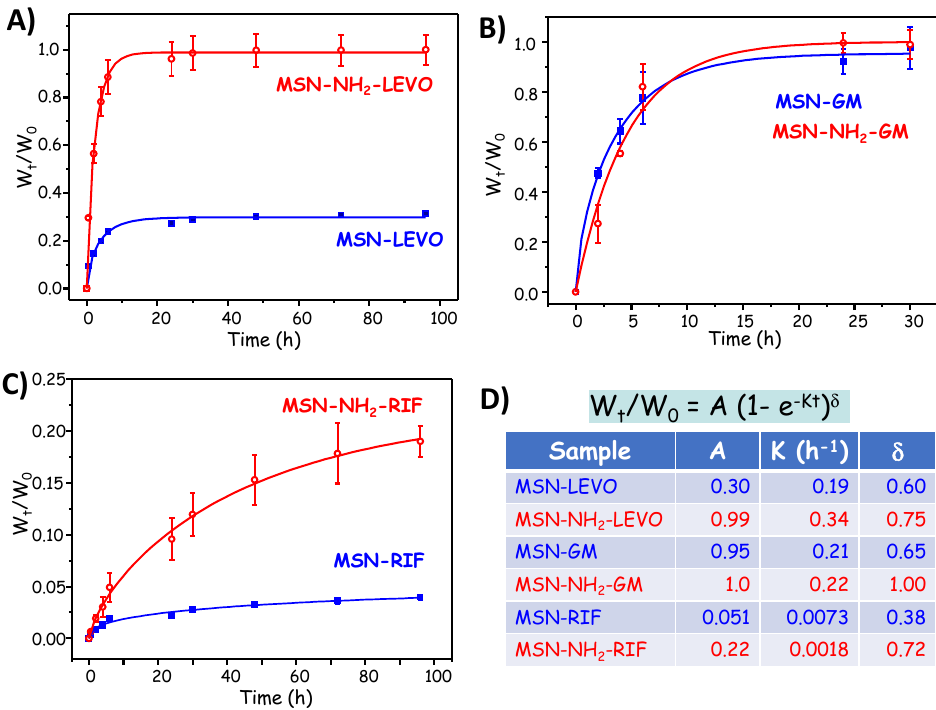
Figure 3. Drug release curves of three antibiotics: ( A ) levofloxacin (LEVO); ( B ) gentamicin (GM); and ( C ) rifampicin (RIF), from pure-silica (MSN) and amino-modified (MSN-NH 2 ) MSNs. ( D ) Kinetic parameters derived from the fit of the experimental data to theoretical kinetic model using the equation W t /W 0 = A (1 − e − kt ) δ , where W t is the amount of antibiotic released at t time, W 0 is the initial amount of loaded drug, A is the maximum antibiotic release at infinite time, k is the release kinetic constant and δ is a dimensionless non-ideality parameter. Adapted with permission from Aguilar et al. [53], Micropor. Mesopor. Mat., published by Elsevier, 2021.